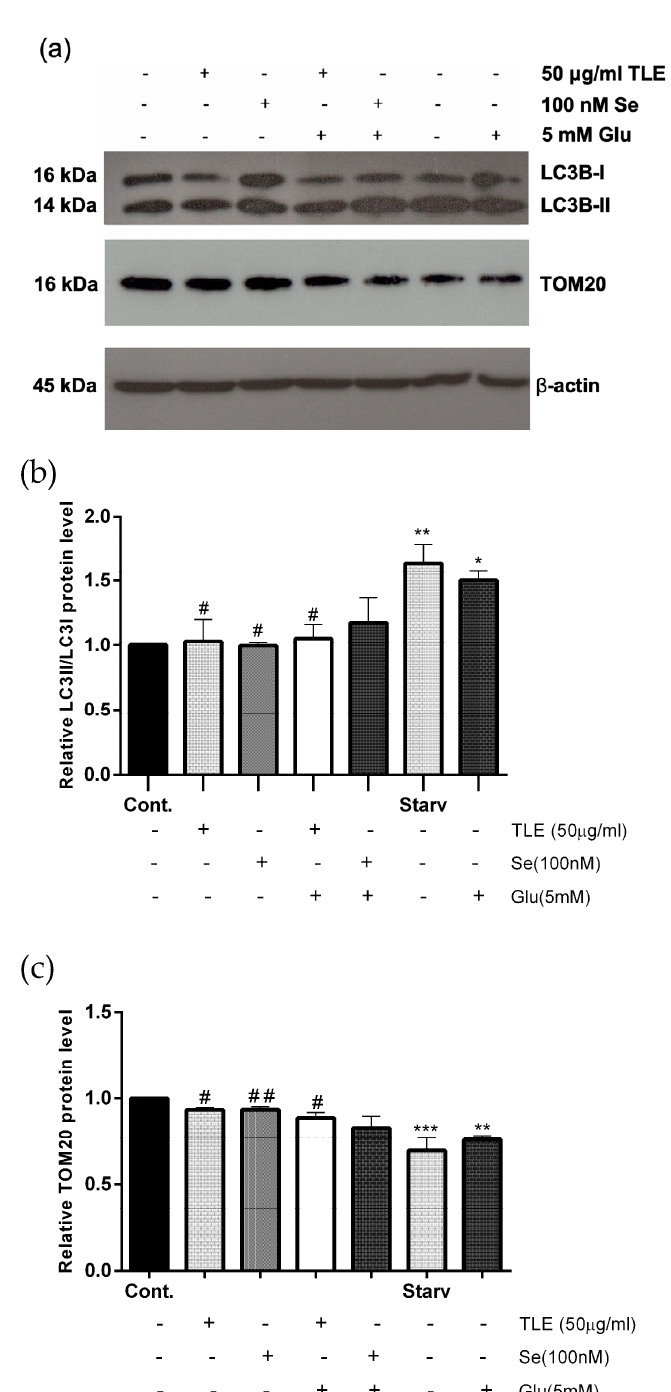
Figure 6. TLE inhibits glutamate-induced excessive mitophagy. HT-22 cells (passage 14,16,17) were pretreated with 50 µ g/mL of TLE or 100 nM selenium followed by 5 mM glutamate for 18 h. ( a ) The protein expression level of LC3B (autophagy) and TOM20 (mitochondria) were analyzed by Western blot, and β -actin served as the loading control. Relative protein levels of ( b ) LC3B and ( c ) TOM20 were quantified by densitometry and the mean data from at least three independent experiments were normalized to the results. Cont, untreated control; Starv, starvation. The data represent the means ± SEM. * p value < 0.05, ** p value < 0.01, *** p value < 0.005 compared with untreated control # p value < 0.05, ## p value < 0.01 compared with only the glutamate-treated group.